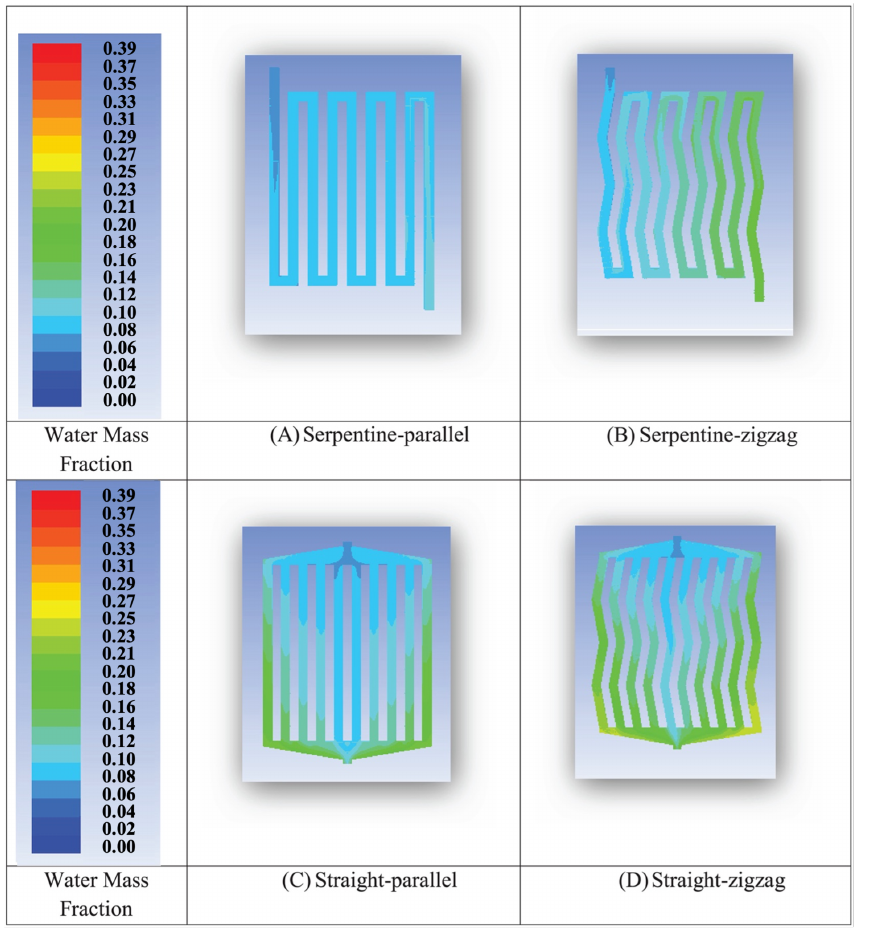
Figure 12. The water mass fraction distribution: ( A ) serpentine; ( B ) serpentine zigzag; ( C ) parallel; ( D ) parallel zigzag